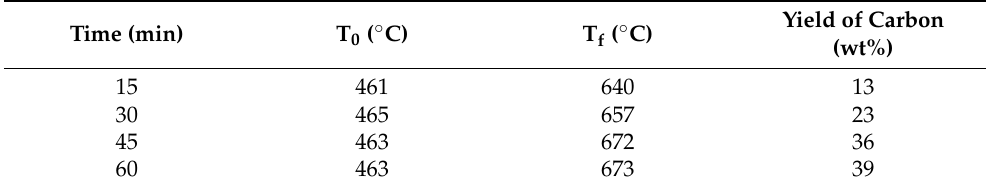
Figure 2. The TGA ( a ) and the Raman spectra ( b ) of SS@CNTs synthesized using different time intervals. Table 2. The corresponding parameters of TGA of the SS@CNTs synthesized using different time intervals.